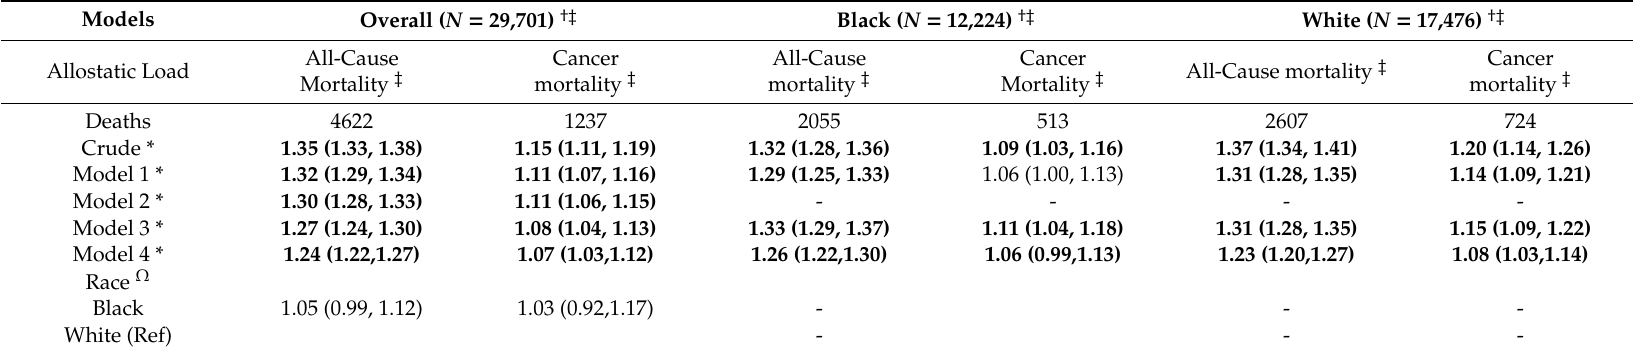
Table 3. Multivariable Adjusted Cox Proportional Hazards Models * for the Association †‡ Ω of Allostatic Load Score with All-Cause and Cancer-Specific Mortality, Overall and by Race in the REGARDS cohort.